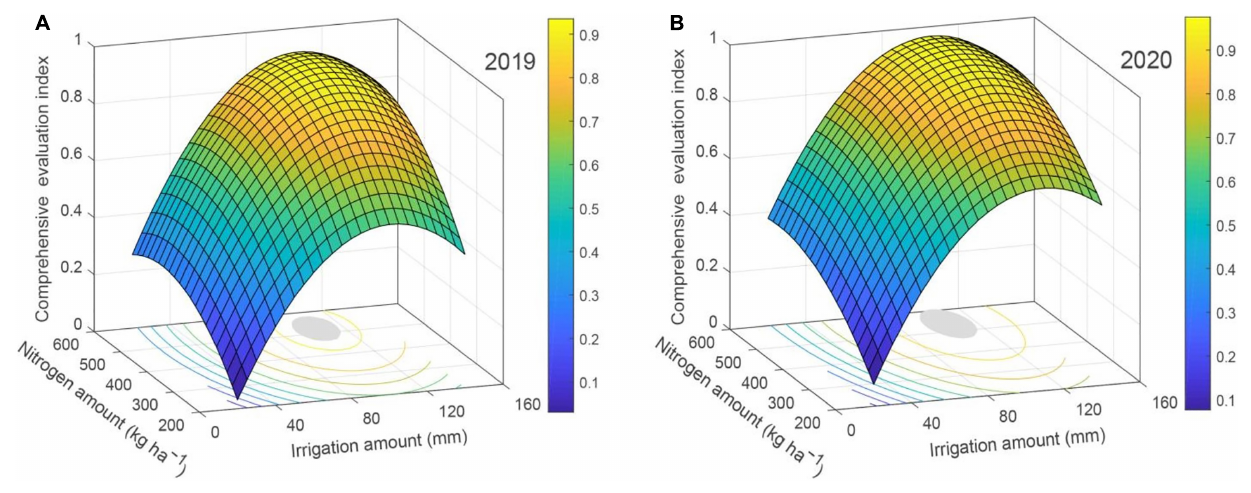
nitrogen amount interval were 95.76–116.59 mm and 466.78– 575.75 kg ha − 1 in 2019, and 95.00–117.00 mm and